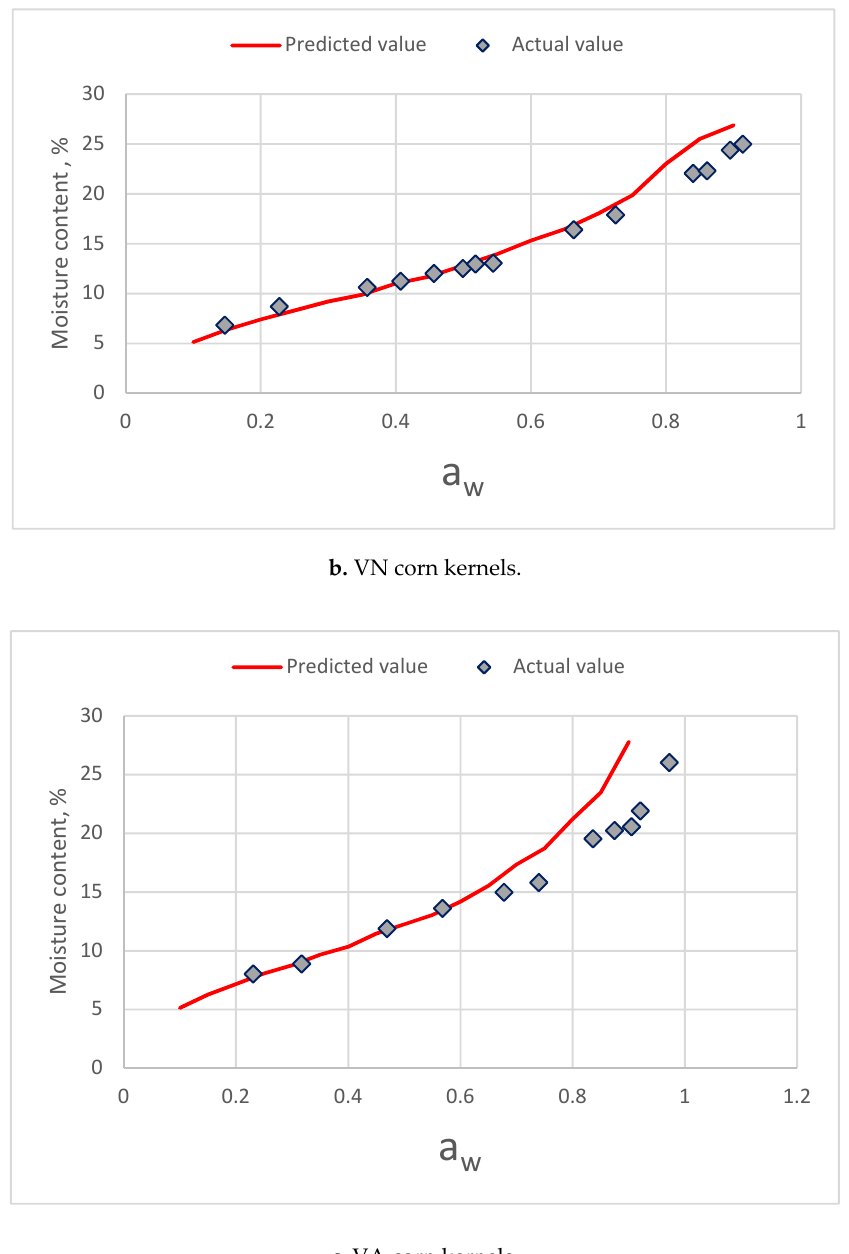
Figure 9. Comparing of the predictive values from the component model and the actual isotherm moisture of three varieties of corn kernel. (a. VR corn kernels; b. VN corn kernels; c. VA corn